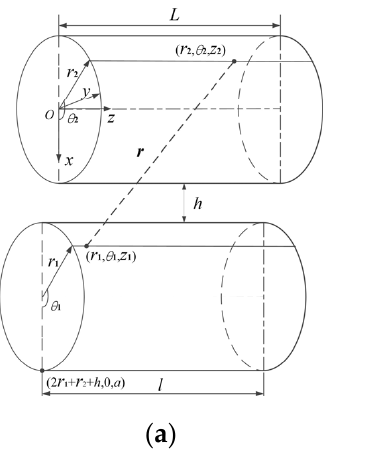
Figure 2. The ( a ) continuum model and coordinate system of two parallel single-walled CNTs and the ( b ) atom models of the MD simulations.